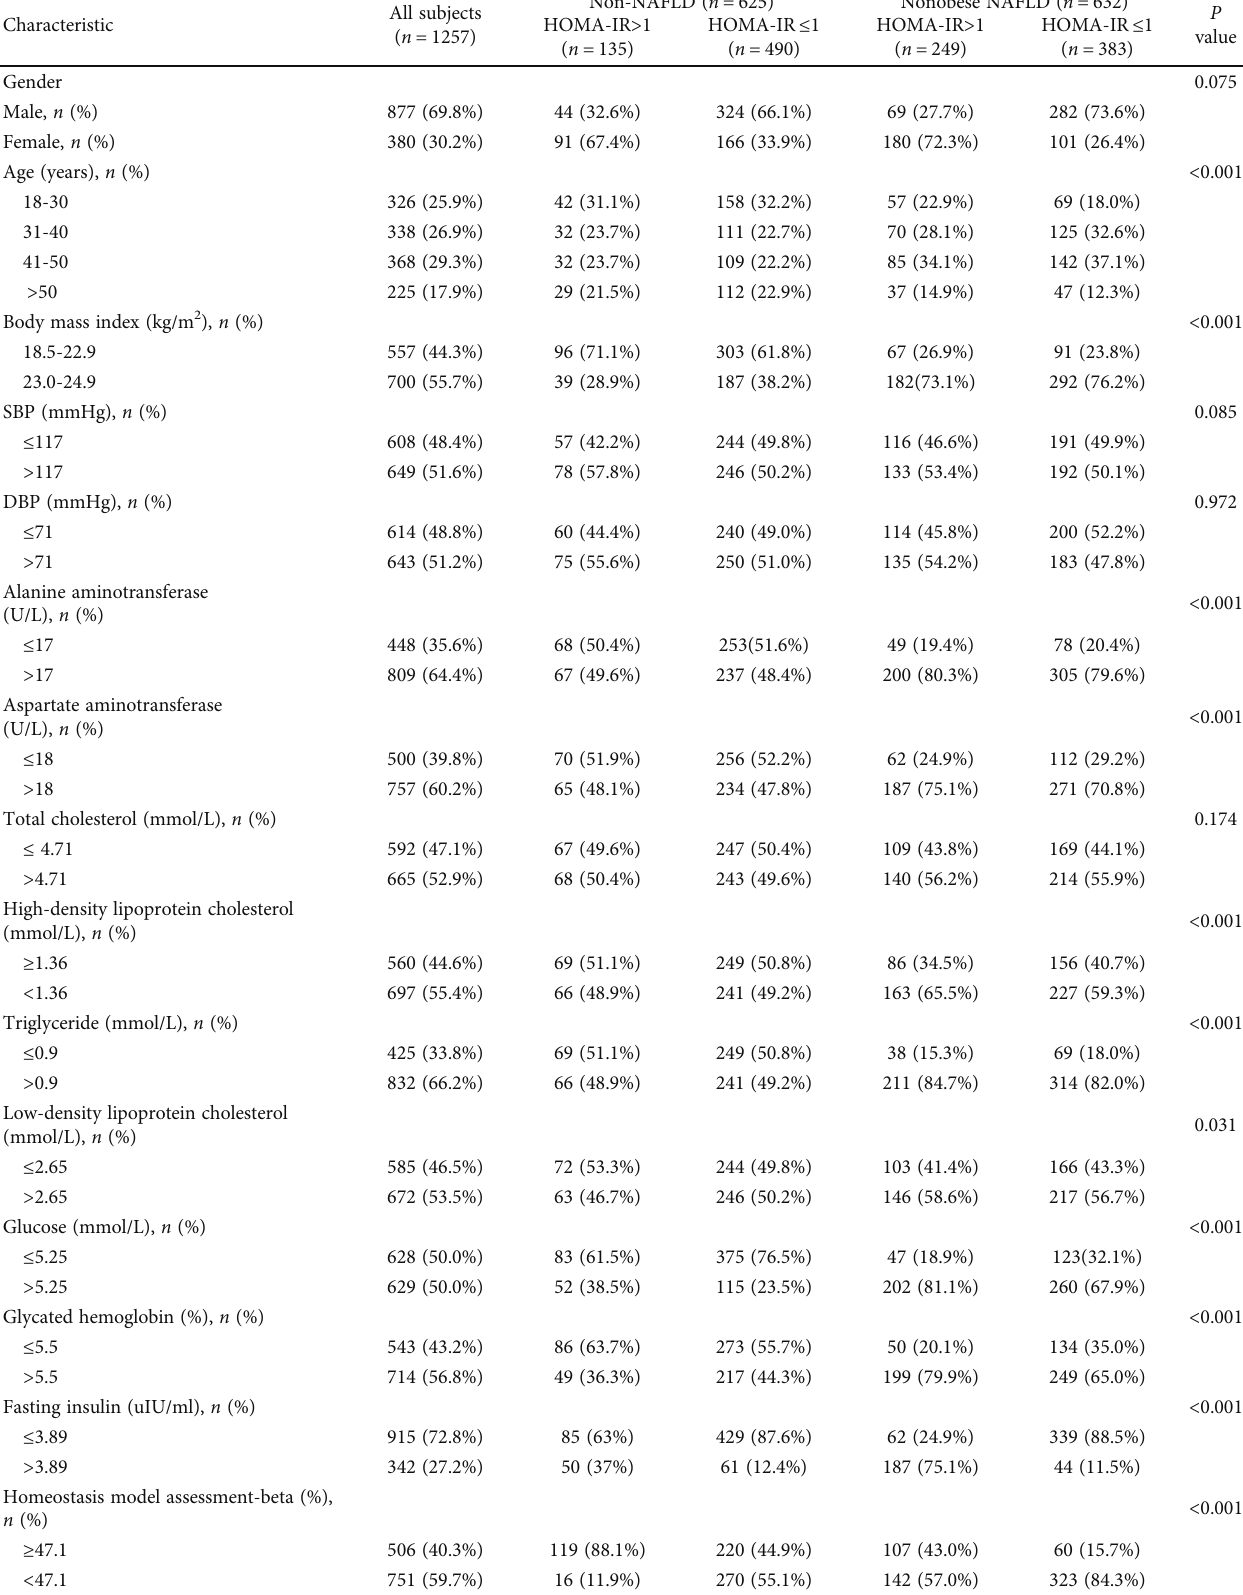
Table 1: Distributions of study variables among participants with and without nonobese